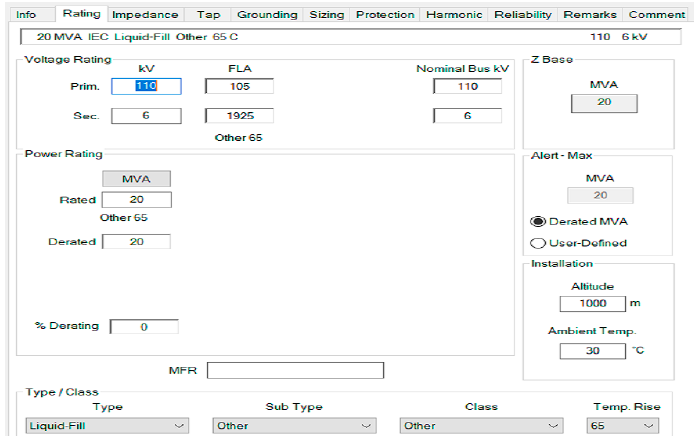
Figure 12. The nominal data for the transformer T2.